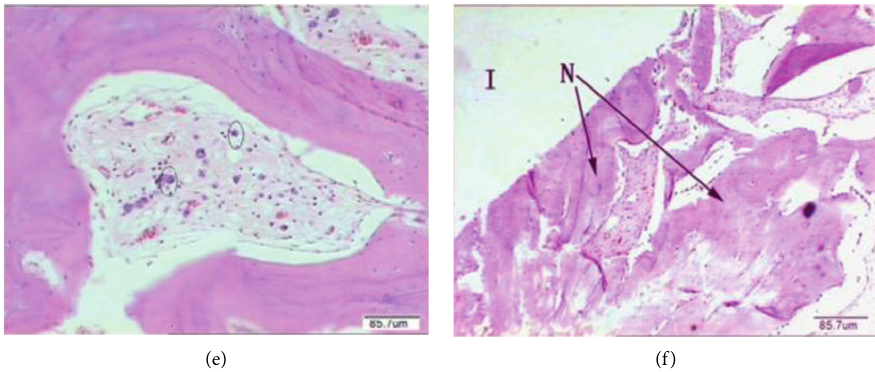
Figure 11: Histological photographs of the implant/bone interfaces around uncoated (a, b), Ca-P coating (c, d), and MgF 3 months after the operation (I: implant; N: newly formed trabecular bone; circle: magnesium granules)